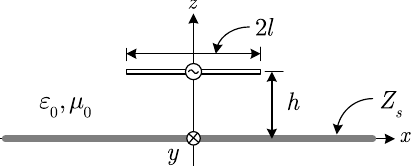
Fig. 4. Antenna above periodic metasurface or surface impe-